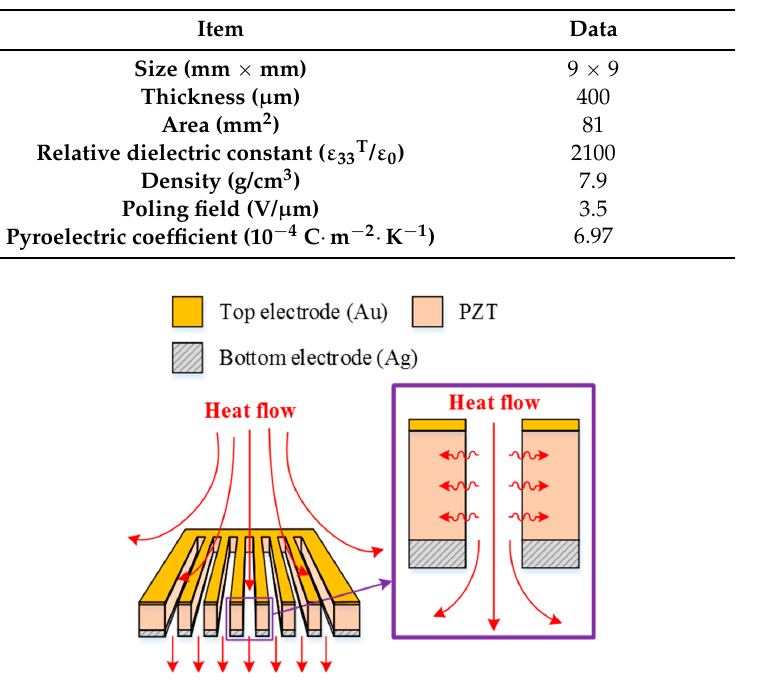
Figure 1. Schematic diagram for describing operations of the strip PZT pyroelectric cell.